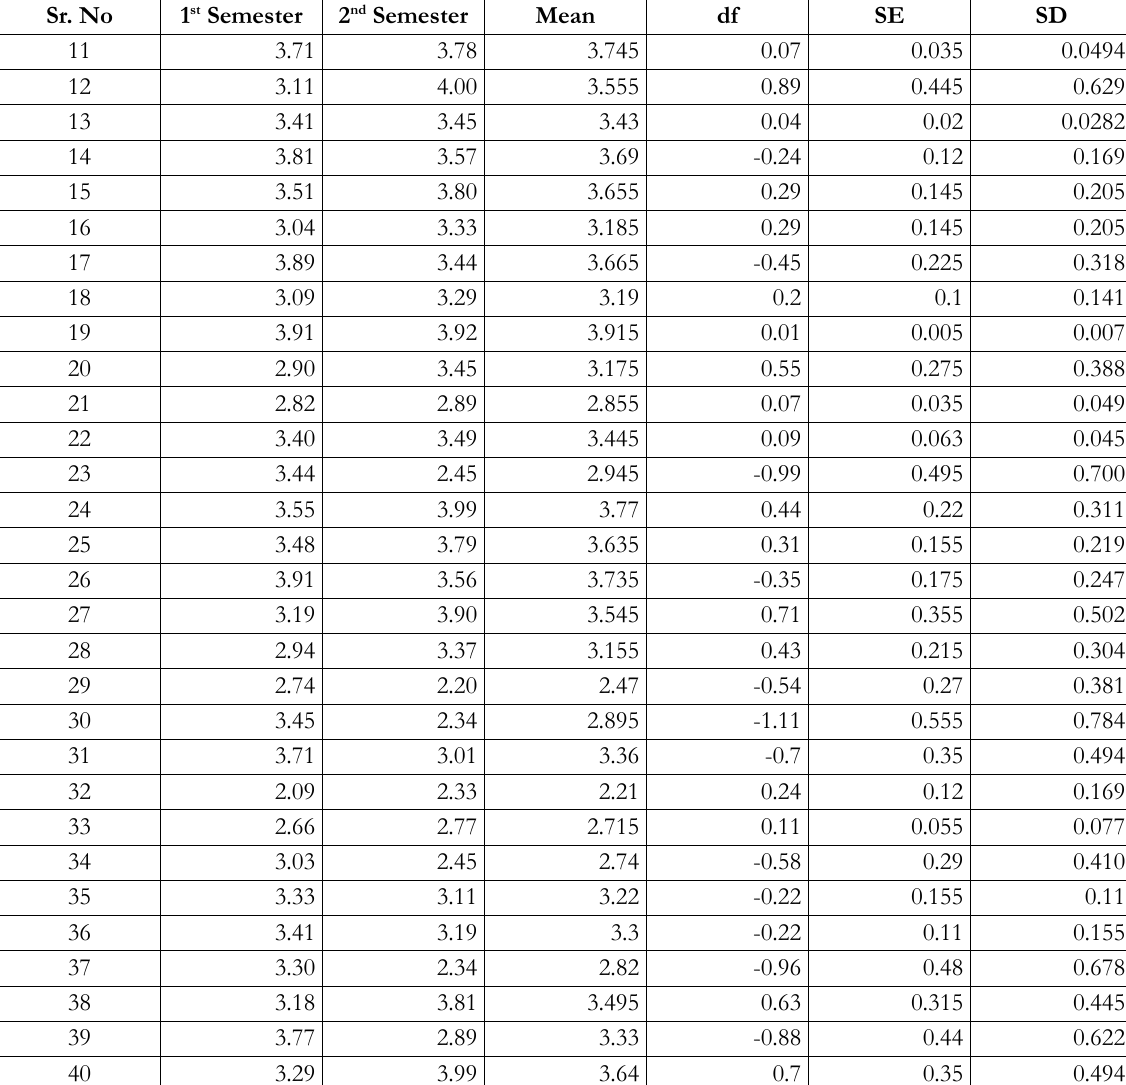
Table 1. Descriptive Statistics Results of Students’ Academic Achievements in 1 st and 2 nd